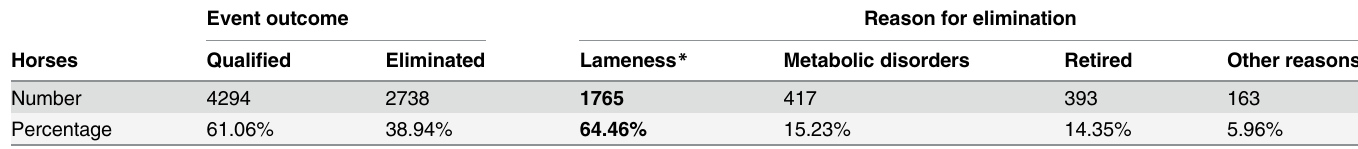
Table 1. Distribution of horses according to the outcome of the event and the reason for elimination.